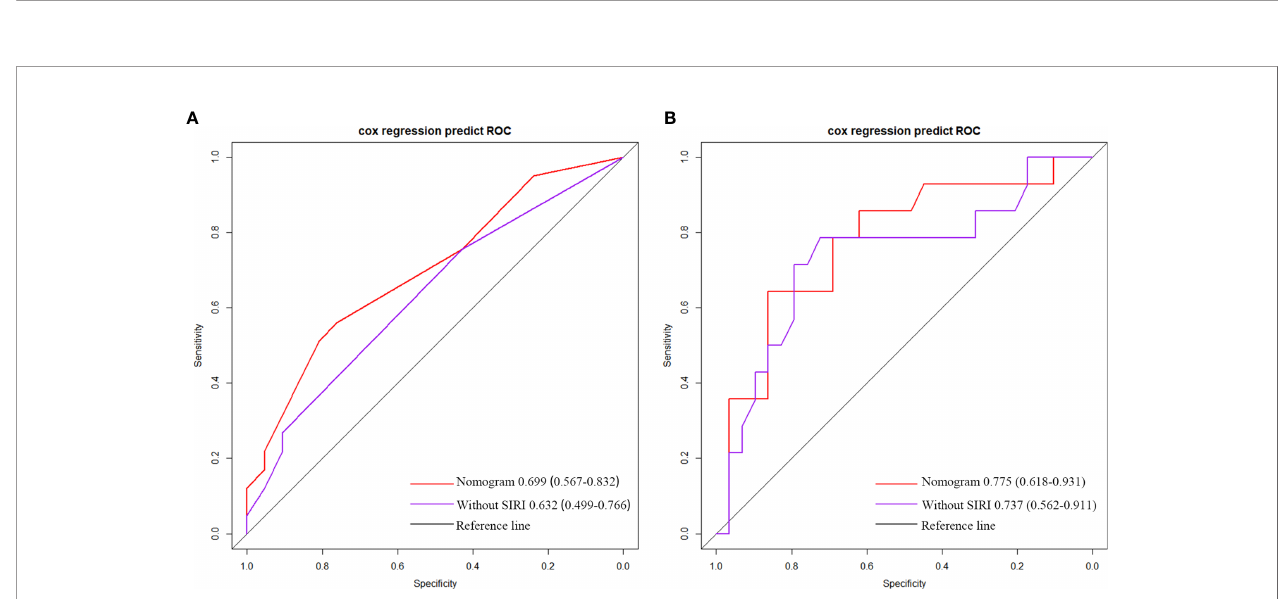
FIGURE 5 | Calibration curve for predicting the 1-year, 2-year and 3-year OS (A – C) in patients with grade IV glioma and for predicting the 2-year, 3-year and 4-year OS (D – F) in patients with grade III glioma.